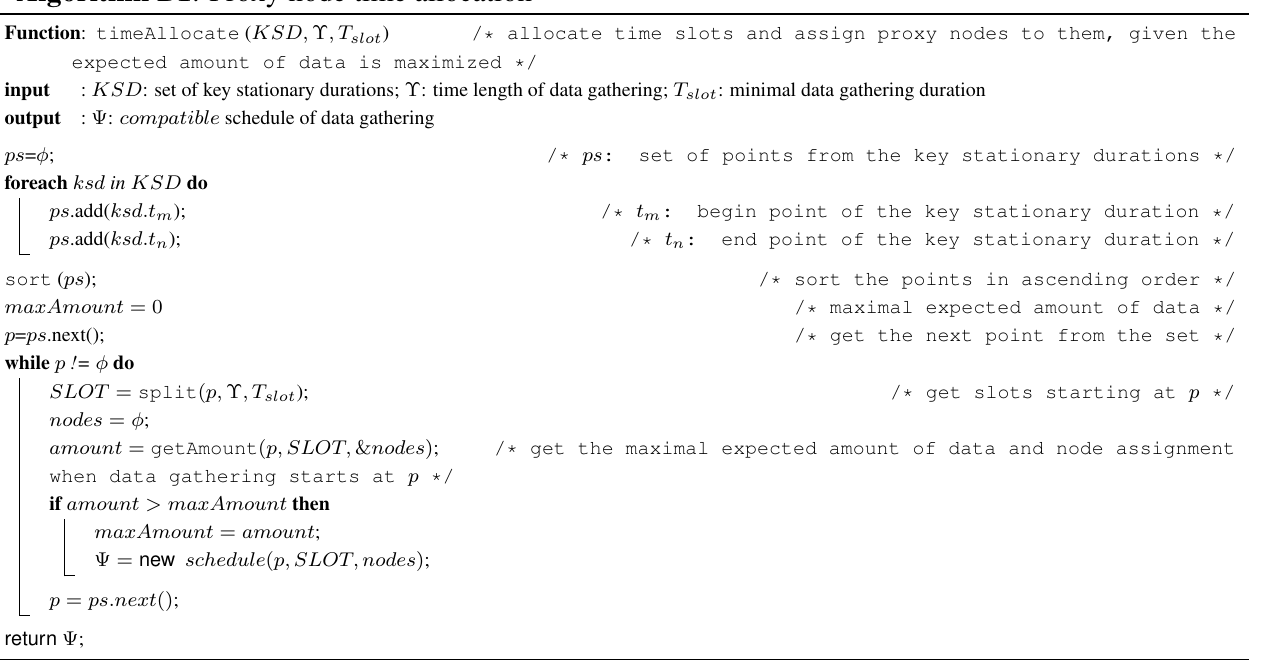
Algorithm B1 : Proxy node time allocation